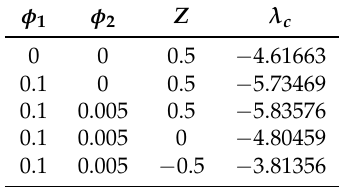
Table 9. Critical values λ c for selected values of φ 1 , φ 2 , and Z when Pr = 6.2 and d =